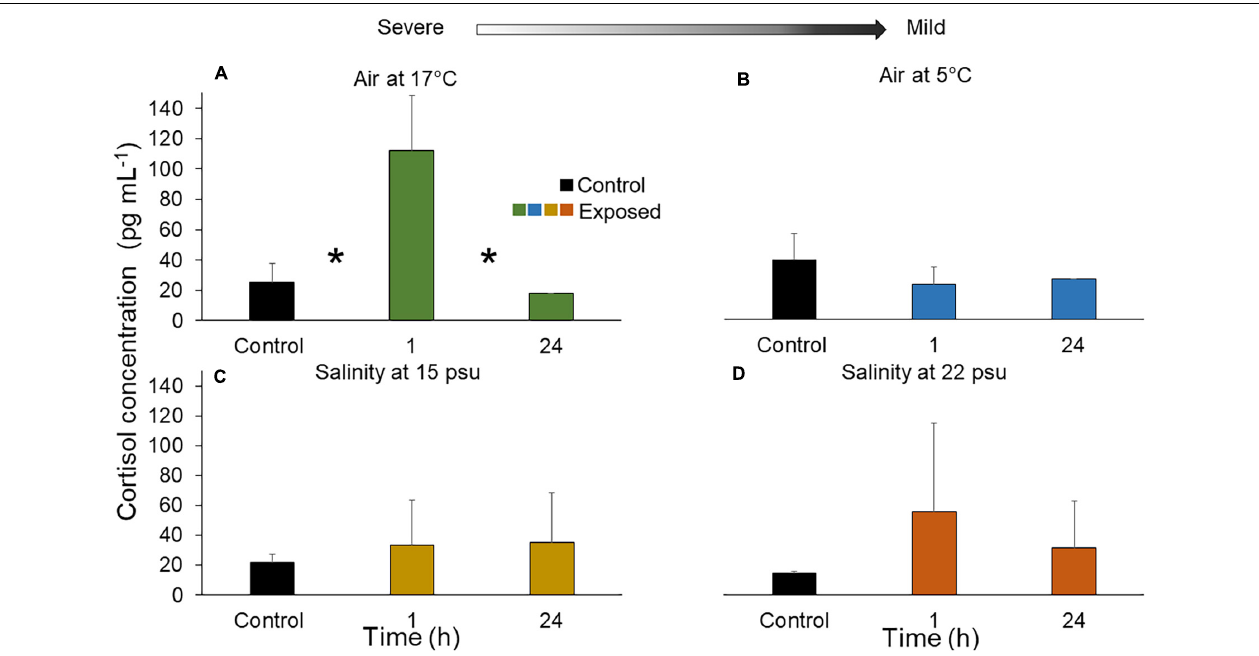
FIGURE 6 | Cortisol concentration (pg mL - 1 ) after exposure of sea cucumbers to (A) 17 ◦ C air (B) 5 ◦ C air (C) 15 psu salinity and (D) 22 psu salinity. The asterisk (*) indicates significant differences within one treatment group ( p < 0.05), in this case (A) the concentration between control individuals and those sampled at the 1 h mark was significantly different as well as the cortisol concentration between those sampled at 1 and 24 h. There was no statistical difference between the control and exposed individuals after 24 h ( p > 0.05). Arrow indicates severe and mild stressors relative to the control. Measurements were made immediately after the exposure (1 h) and after a 23 h recovery period (total of 24 h). Main statistical results are shown in Supplementary Table 2